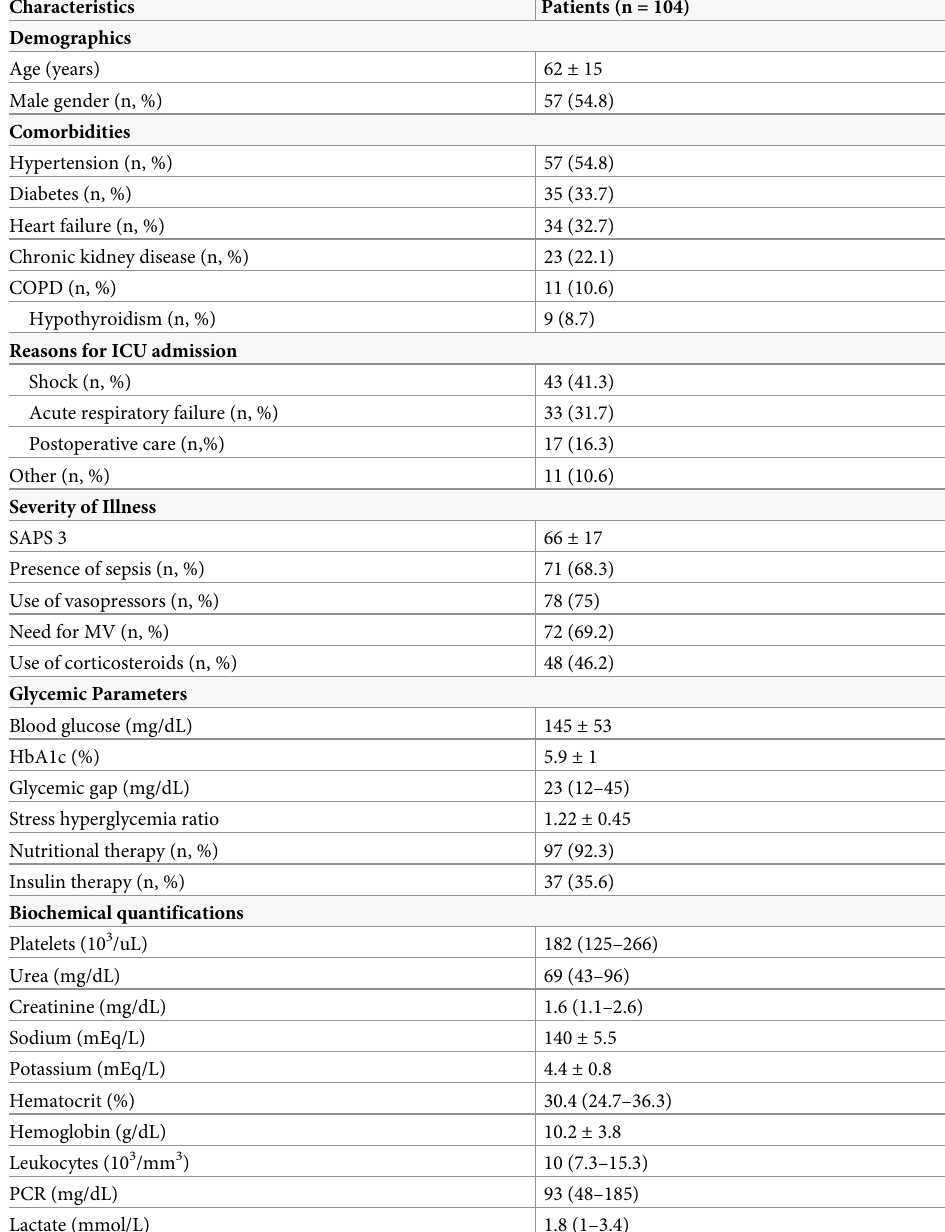
Table 1. Baseline demographic and clinical characteristics at the time of intensive care unit